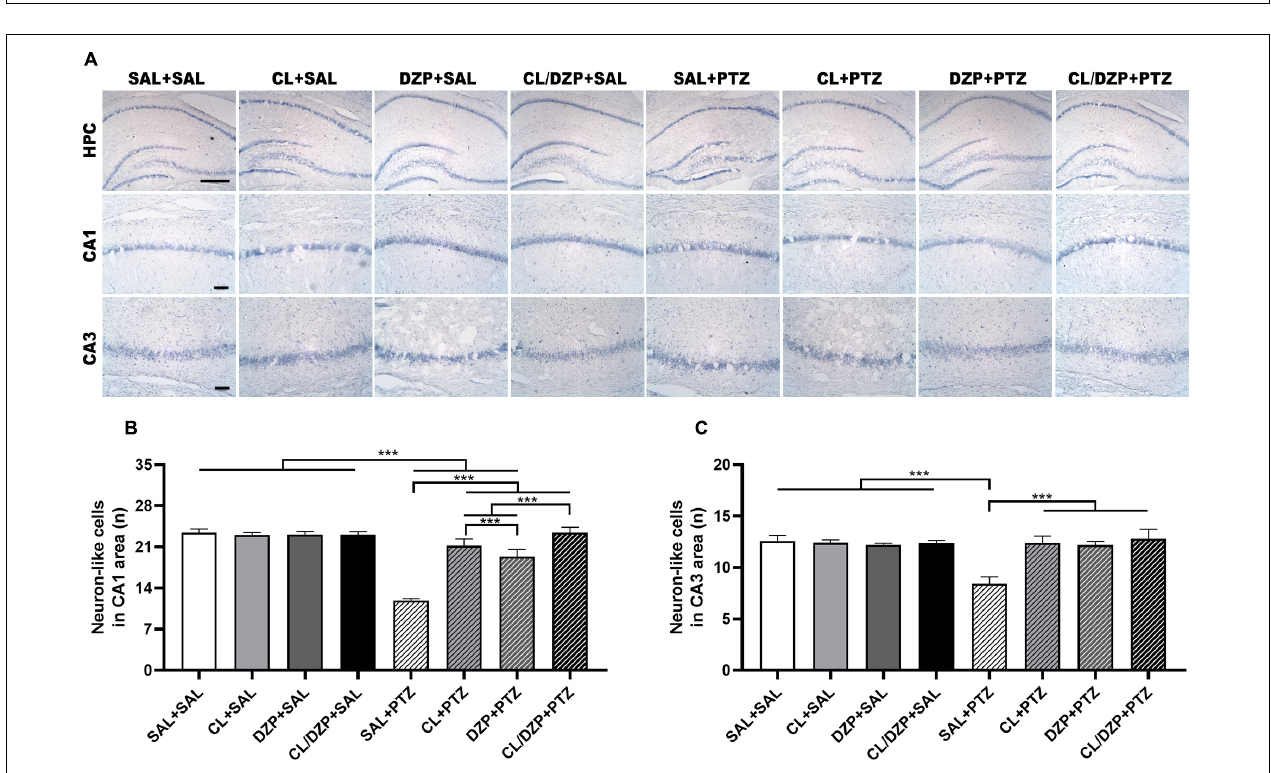
FIGURE 6 | Nissl staining of the rat hippocampus in PTZ-induced seizures pretreated with Curcuma longa and/or diazepam. (A) Representative images. (B) Quantitative data on the number of neuron-like cells in the CA1 region. (C) Quantitative data for the number of neuron-like cells in the CA3 region. Data are presented as the mean ± SD ( n = 9 per group); *** p < 0.001. SAL, saline; CL, Curcuma longa ; DZP, diazepam; PTZ, pentylenetetrazol; HPC, hippocampus. Scale bar = 200 µ m. CA1 and CA3: scale bar = 50 µ